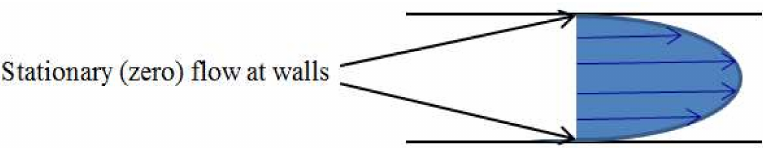
Figure 11. Velocity profile of fluid flow through solid boundaries under ideal